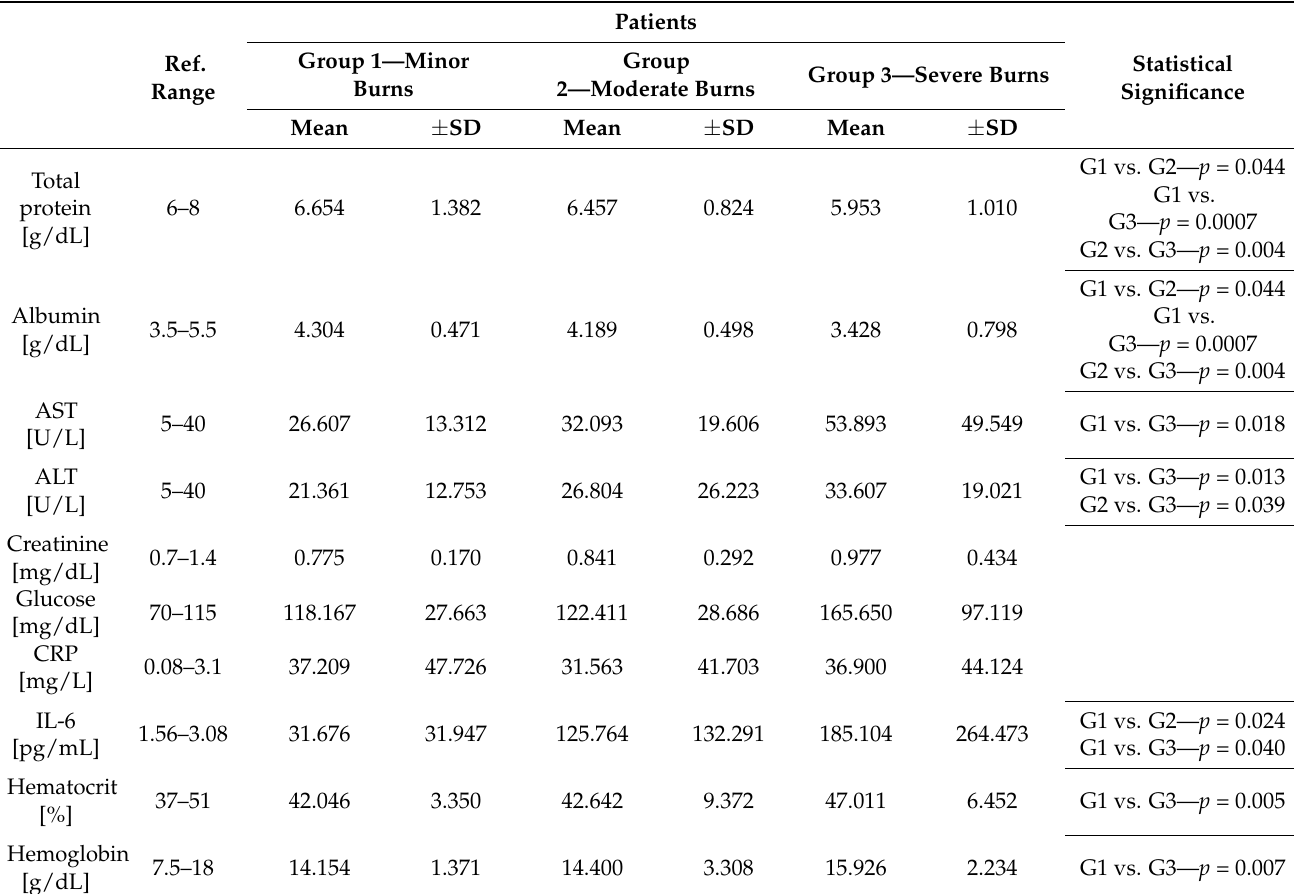
Table 2. Selected blood parameters determined in patient groups 1–3 (G1, G2, G3).